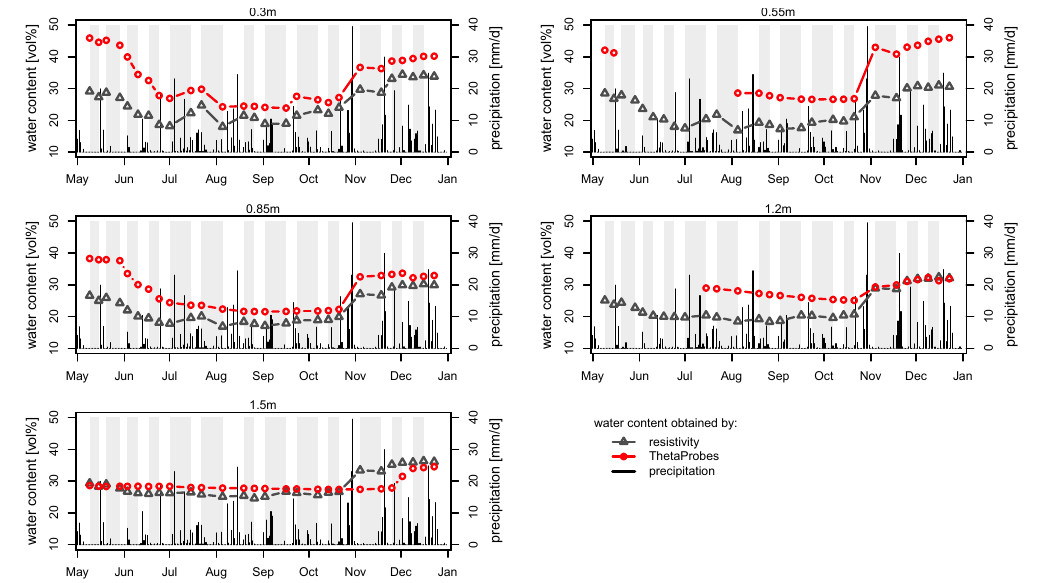
Figure 11. Trend of volumetric water content, obtained by resistivity data and soil moisture sensors (ThetaProbes) with daily precipitation for different depths.